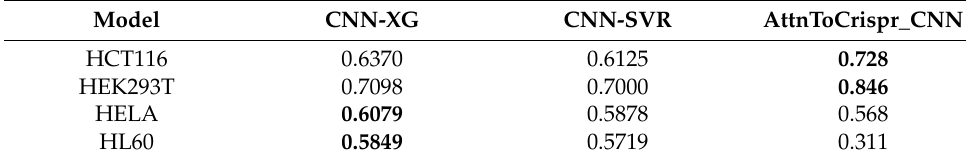
Table 5. Pearson correlations for test scenario